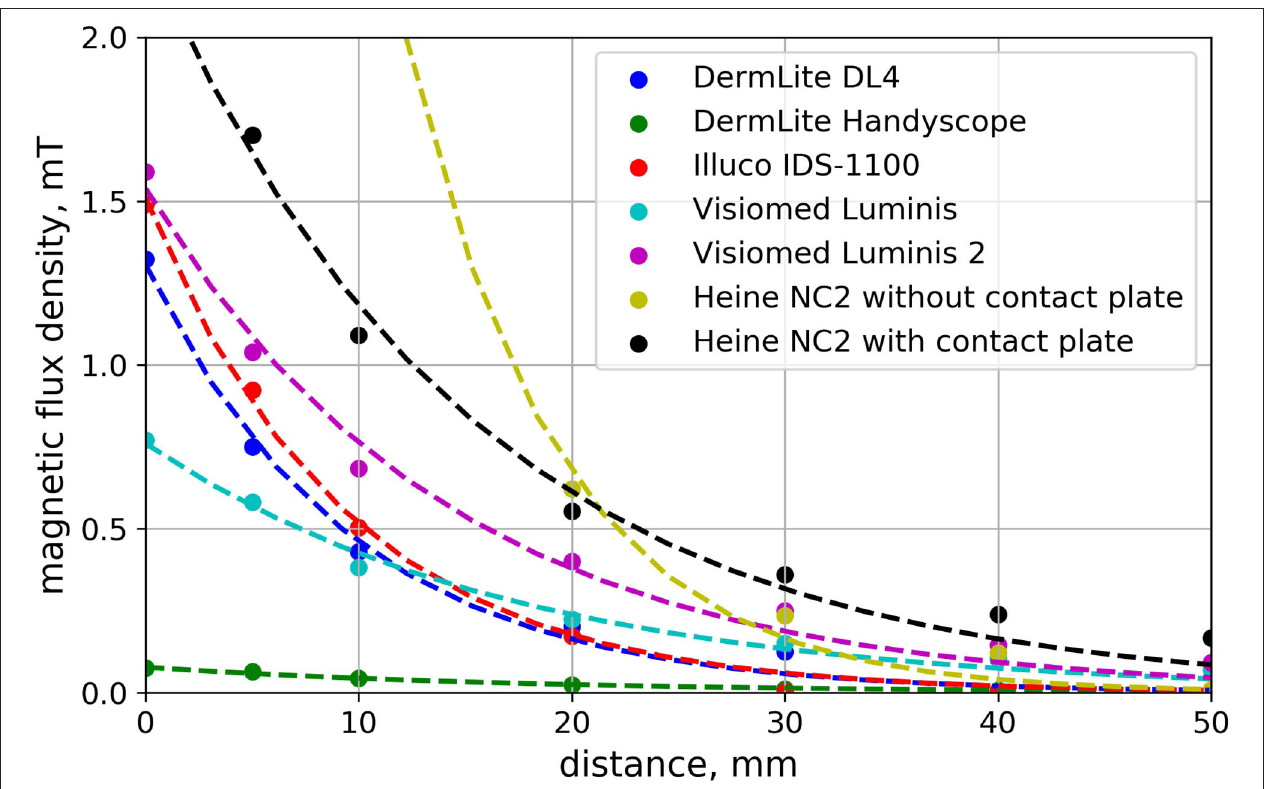
FIGURE 1 | Dependence of the magnetic flux density on the distance from the dermoscope faceplate. Each curve was determined for a path that starts at the point over a faceplate corresponding to the maximum absolute value of measured magnetic flux density.